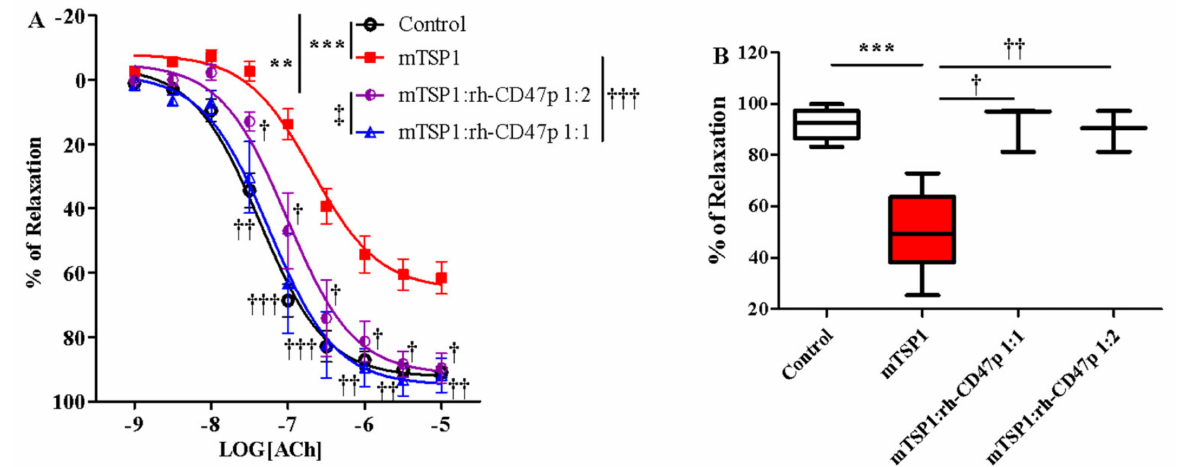
Figure 5. Post-treatment with recombinant human CD47 peptide (rh-CD47p) exerts restorative effect on injury to va- sodilation by monomeric TSP1 (mTSP1). mTSP1 was incubated 15 min prior to coincubation with rh-CD47p for 45 min. ( A ) Concentration-response curves of isolated mouse thoracic aorta exposed to mTSP1 alone or the combination of mTSP1 and rh-CD47p in two different molar ratios. Substantial injury to vasodilation caused by mTSP1 was restored to control level (two-way ANOVA followed by a Bonferroni posthoc test; n = 4, *** p < 0.001, mTSP1 vs. control; ** p < 0.01, mTSP1:rh-CD47p 1:2 vs. control; † p < 0.05, †† p < 0.01, and ††† p < 0.0001, mTSP1:rh-CD47p 1:1 or 1:2 vs. mTSP1; ‡ p < 0.05, mTSP1:rh-CD47p 1:1 vs. 1:2). ( B ) Percentages of relaxation at 10 µ M acetylcholine are presented as box and whisker plots showing median, 1st quartile, 3rd quartile, and 95% CI. Two doses of rh-CD47p brought impaired vasorelaxation close to control ( n = 4, *** p < 0.0001, TSP1 vs. control; † p < 0.05, mTSP1:rh-CD47p 1:1 vs. mTSP1; †† p < 0.01, mTSP1:rh-CD47p 1:2 vs.